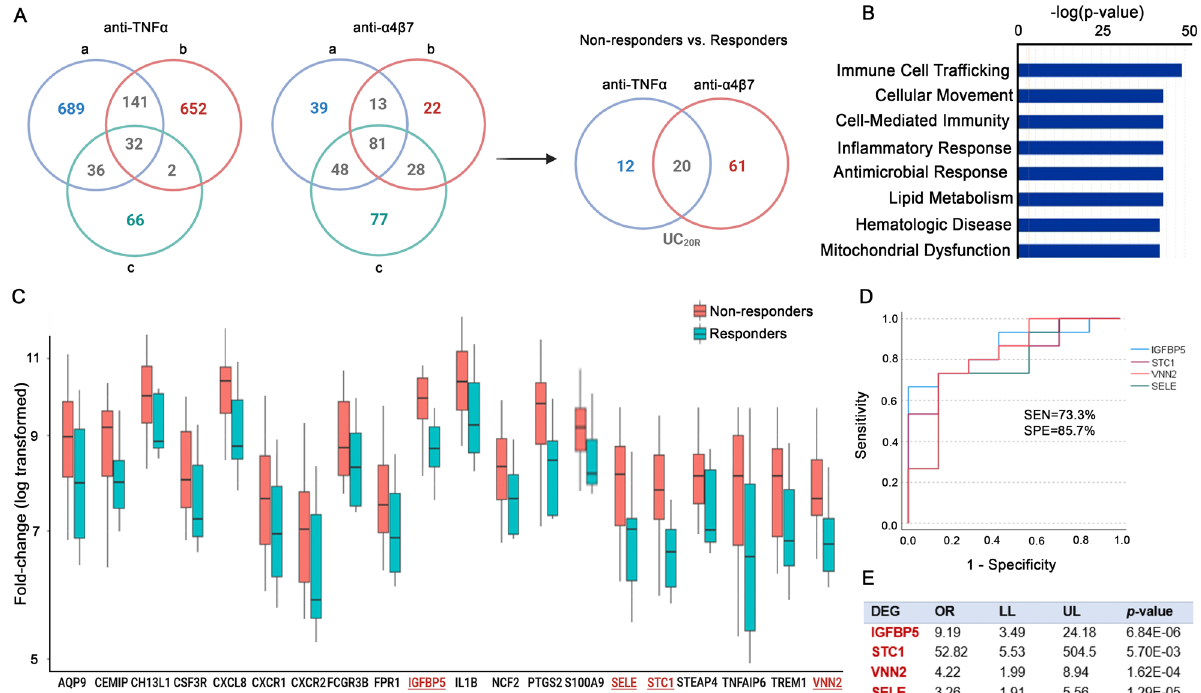
Figure 5. Differentially expressed genes in non-responders to anti-TNFα and anti-α4β7 treatment reflecting treatment “failure” and “prediction” to therapy outcomes. ( A ) DEGs were generated from samples (GSE12251, GSE73661) obtained during and after anti-TNFα treatment (non-responders vs. responders) following different dosage and time points (a: 5 mg/kg (8 weeks; GSE12251), b: 10 mg/kg (8 weeks; GSE12251), c: 10 mg/kg (4–6 weeks; GSE73661). Additional DEGs were generated from samples obtained during and after the course of anti-α4β7 therapy (a: 6 weeks, b: 12 weeks, c: 52 weeks; GSE73661). Intersection between resistant gene following anti-TNFα (32 genes) and anti-α4β7 (81 genes) yielded 20 shared DEGs representing “failure” to both therapies, i.e. resistant DEGs (UC 20R ) (LIMMA R Package, p < 0.05, FC |1.5|, DEGs). ( B ) Canonical pathway analysis revealed the top enriched molecular pathways in the UC 20R panel from non-responders to anti-TNFα and anti-α4β7 (IPA, FDR < 0.05). ( C ) Expression levels of the UC 20R genes in independent UC samples obtained before anti-TNFα and anti-α4β7 treatment of UC patients (GSE73661). Box plot represents the fold-change (log transformed) of selected DEGs in prospective non-responders (NR) and responders (R). Significantly upregulated IGFBP5, SELE, STC1, and VNN2 were marked in red font. ( D ) “Predictive” performance of the IGFBP5, SELE, STC1, and VNN2 panel, as determined by ROC curve analysis and calculating AUC in both anti-TNFα and anti-α4β7 non-responders before therapy ( p < 0.05). Combined gene analysis of pretreatment data of UC patients (GSE73661) was employed and resulting sensitivity and specificity. ( E ) Multivariate regression analysis showed overexpression of the four genes was associated with higher risk of treatment failure. OR odds ratio, LL lower limit of 95% confidence interval, UL upper limit of 95% confidence